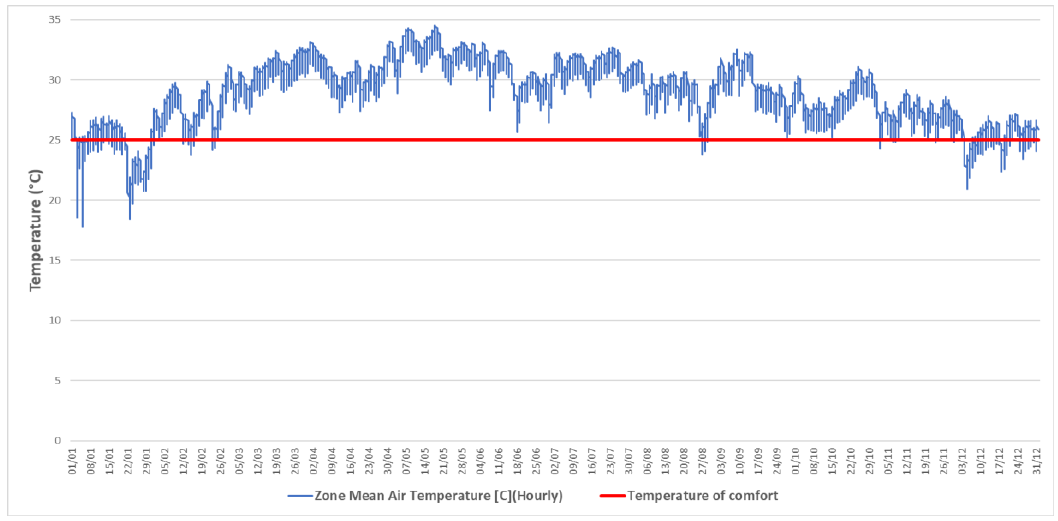
Figure 13. Annual indoor temperatures considering the UHI effect.